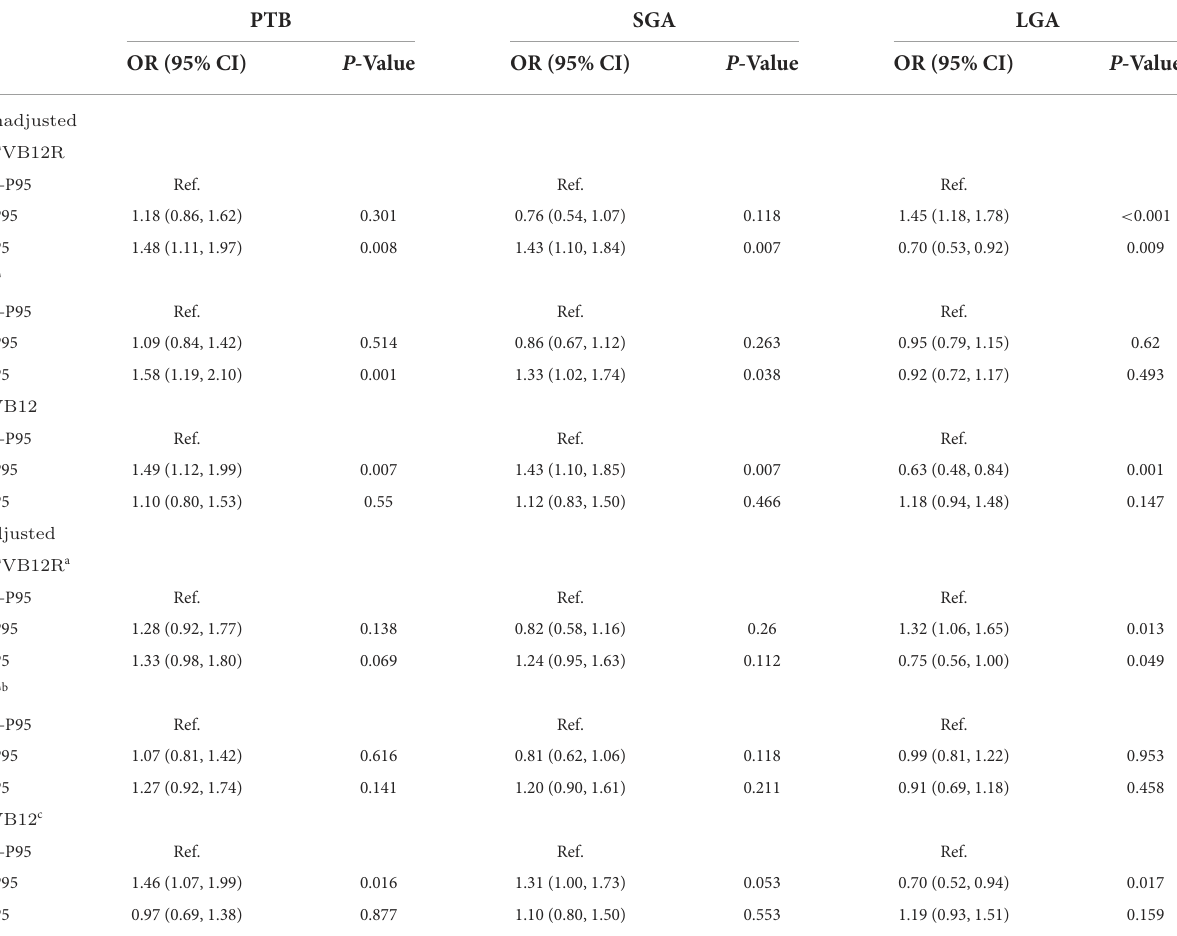
TABLE 7 ORs and 95% CIs for adverse birth outcomes with maternal SF, SVB12 levels, and their ratio. PTB SGA LGA OR (95% CI) P- Value OR (95% CI) P- Value OR (95% CI) P-